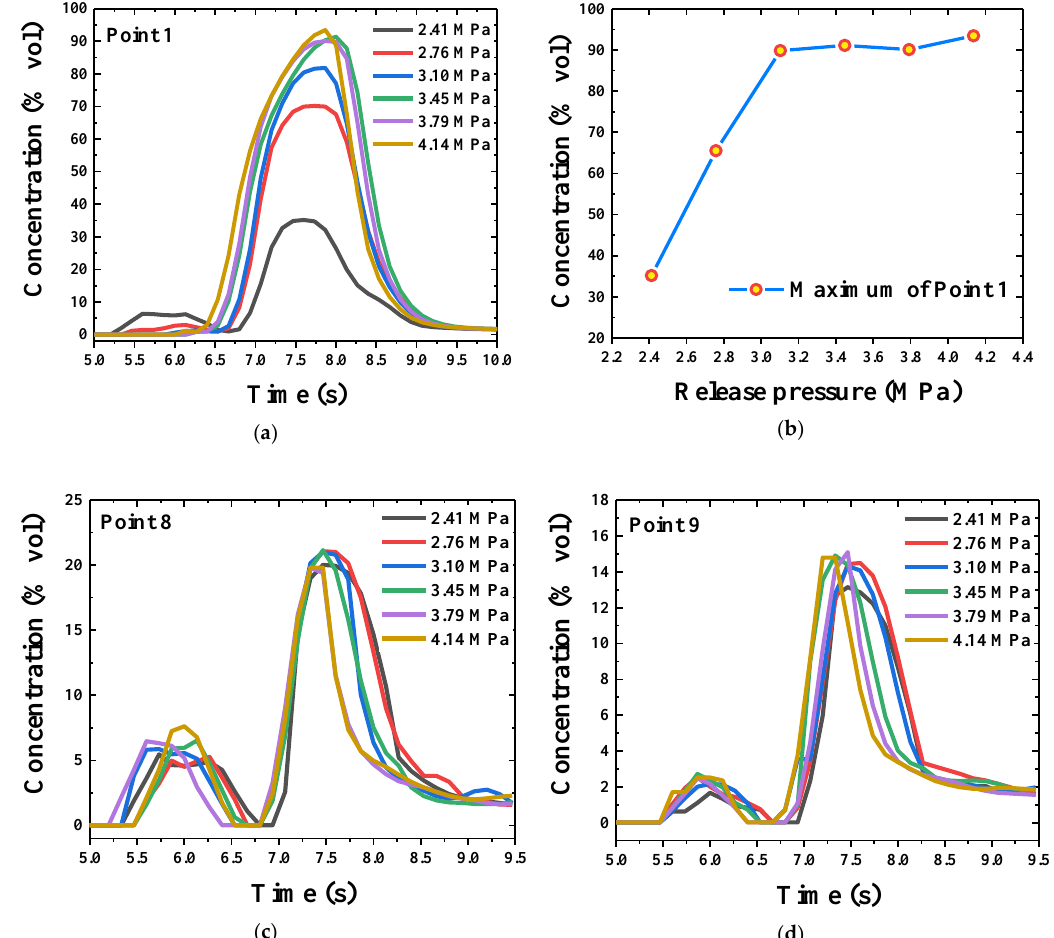
Figure 16. ( a ) Concentration of HFC-125 as a function of time at point 1; ( b ) the maximum value of concentration value with different release pressure at point 1; ( c ) concentration of HFC-125 as a function of time at point 8; ( d ) concentration of HFC-125 as a function of time at point 9.